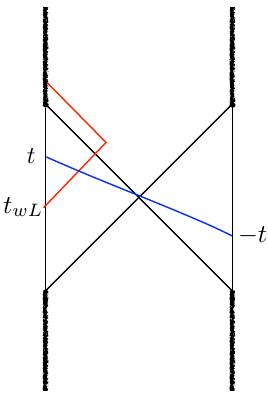
Figure 10 . Exterior OTOC for the AdS 2 black